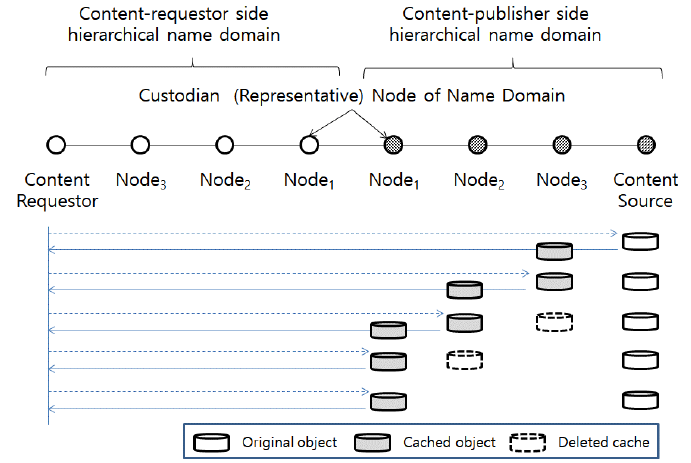
Figure 5. LdC (a limited domain cache policy) procedure using custodian-based NDN.